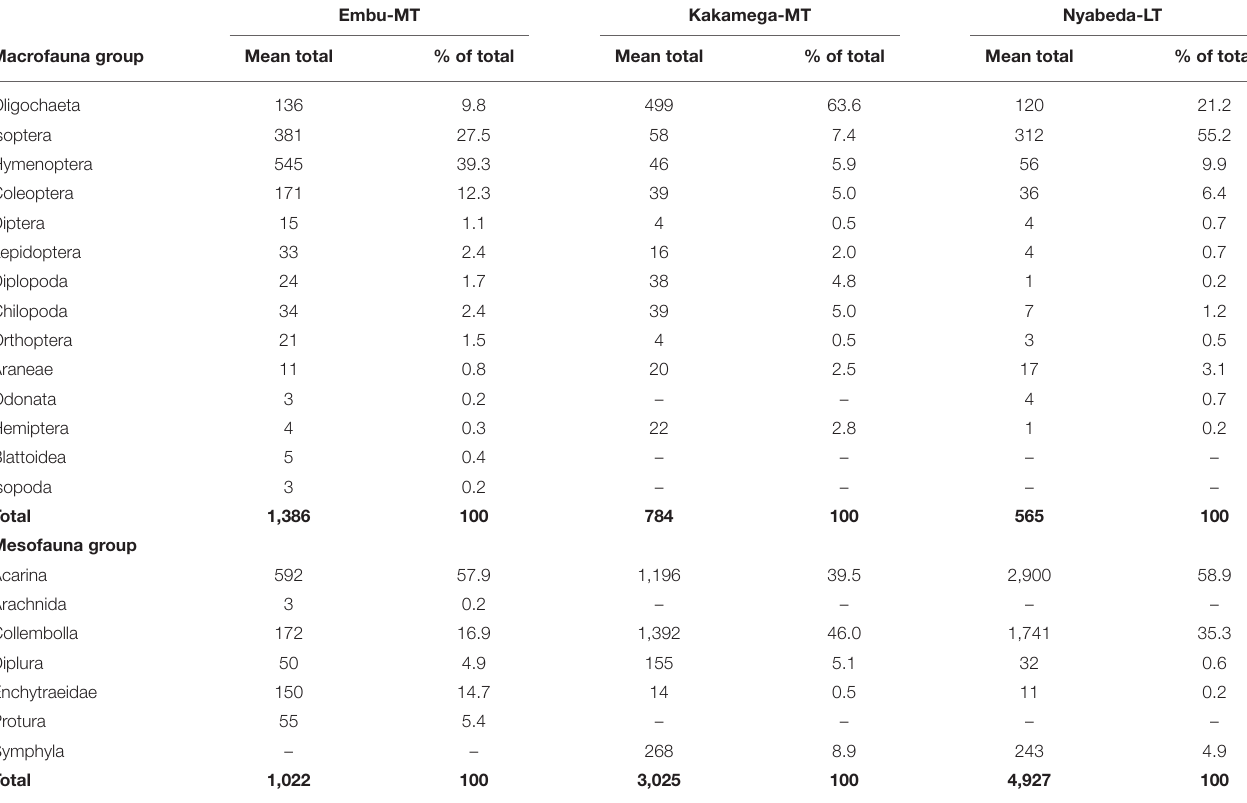
TABLE 3 | Mean total population and percent composition of macrofauna and mesofauna within each group across medium-term (MT) and long-term (LT) trials in Embu, Kakamega, and Nyabeda, Kenya. Embu-MT